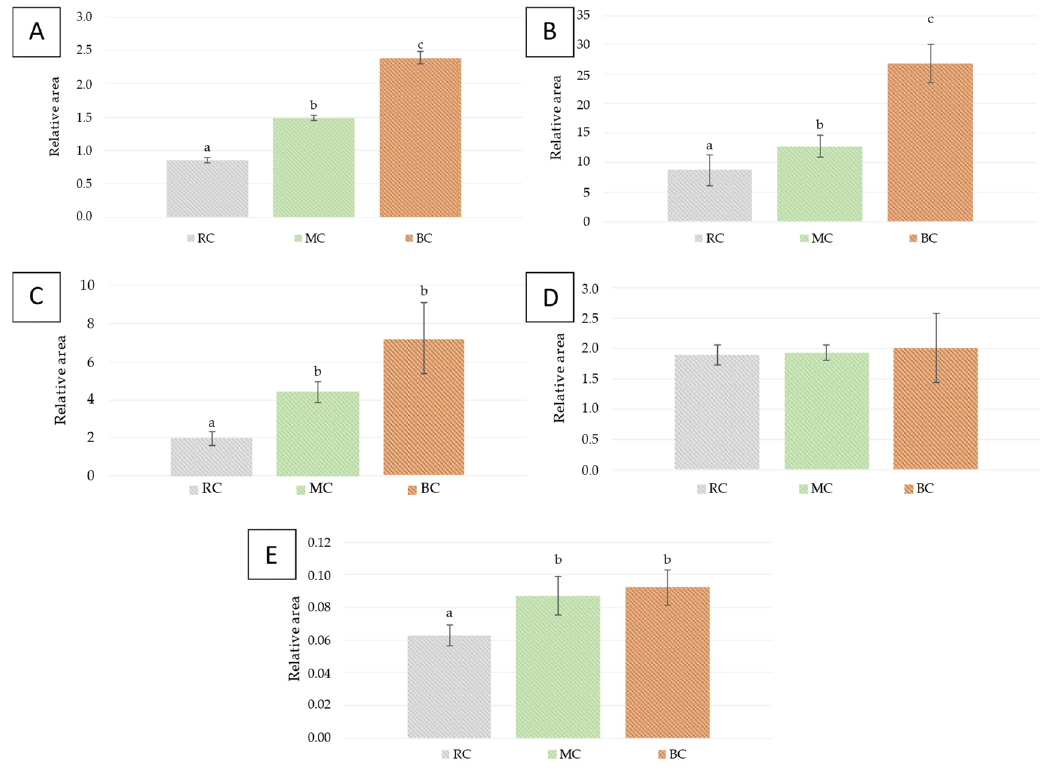
Figure 3. Contents found in wines produced with a prefermentative maceration ( n = 6). Terpenes ( A ), esters ( B ), acids ( C ), 2-methoxy-4-vinylphenol ( D ), and β - damascenone ( E ). Reference wines (RC); wines from frozen crushed grapes (MC) and wines from frozen whole bunches (BC). Different letters over the bars indicate differences ( p < 0.05).